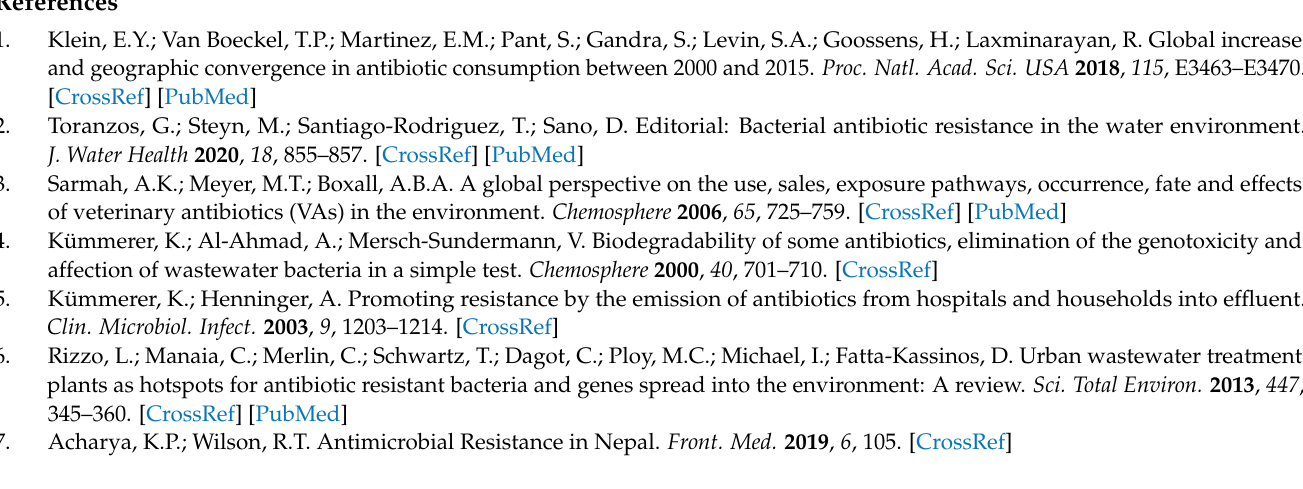
ARGs, Figure S3: Correlation of TC with ARGs, Figure S4: Correlation of intI1 with